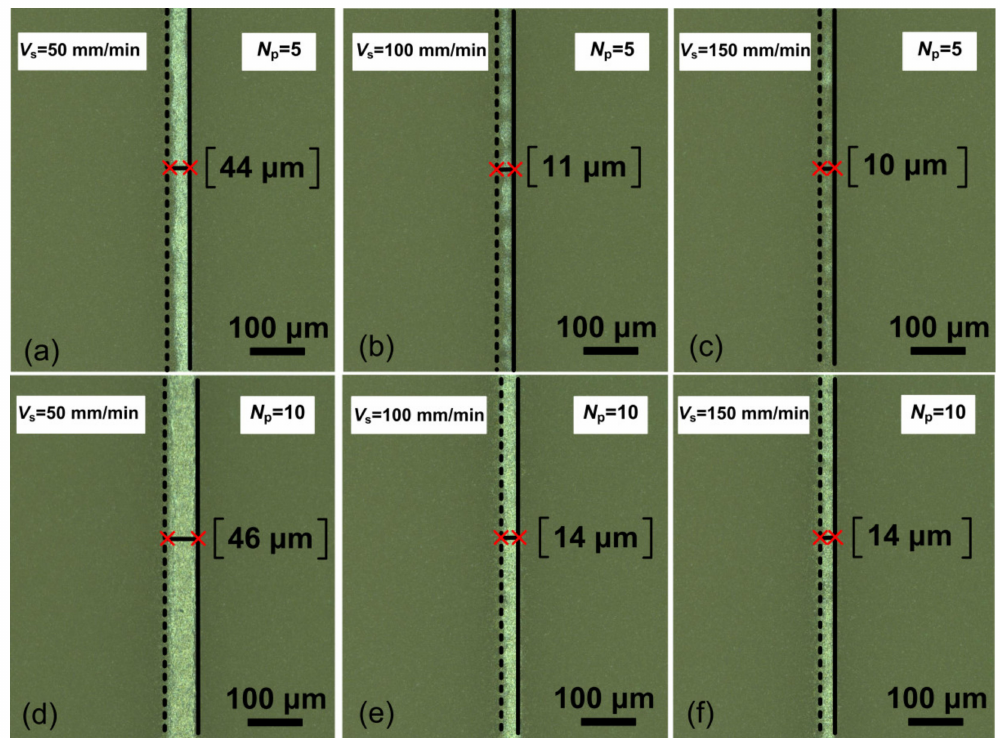
Figure 5. Optical images of platinum lines formed at different values of the substrate speed and the number of print layers ( a ) V s = 50 mm/min and N p = 5, ( b ) V s = 100 mm/min and N p = 5, ( c ) V s = 150 mm/min and N p = 5, ( d ) V s = 50 mm/min and N p = 10, ( e ) V s = 100 mm/min and N p = 10, ( f ) V s = 150 mm/min and N p = 10, at values of FR = 2 and T s = 100 ◦ C.